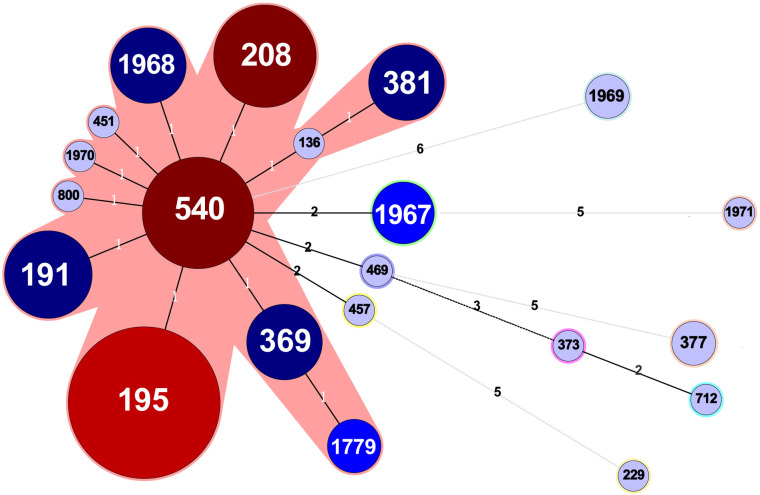
Minimum-spanning tree of 94 Acinetobacter baumannii isolates from CSF and blood based on MLST.Each ST is represented by a circle sized in proportion to the number of isolates represented by that ST, isolates within the pink shaded area are the CC92 isolates, and the number of allelic differences between STs is indicated on the branches. The detailed MLST profiles can be seen in the S2 Table.